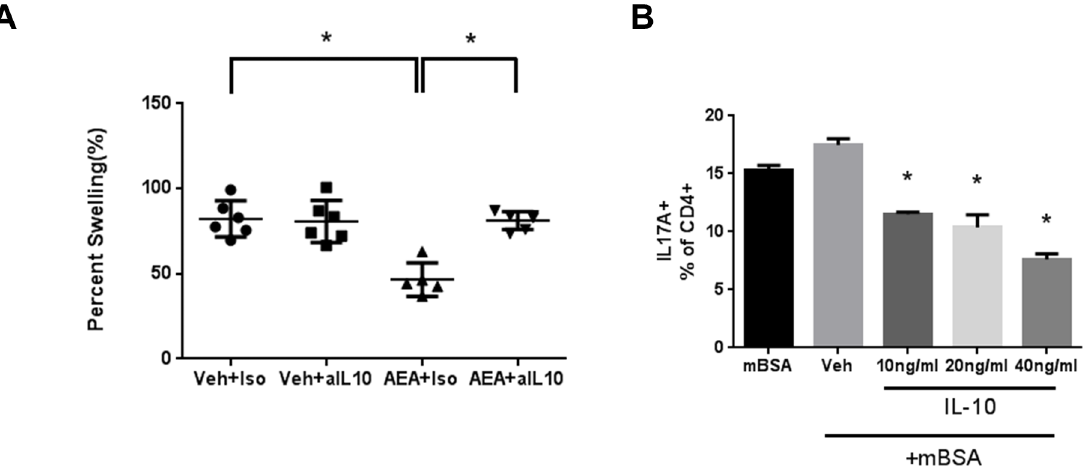
Figure 4. AEA suppresses DTH through IL-10 secretion. [A] Mice were sensitized to mBSA and treated with Vehicle or AEA, as described in Fig 1. An IL-10 neutralizing antibody or isotype control was given i.p. 1 hour before each treatment with AEA or vehicle, and [A] footpad swelling was measured. Footpad swelling data are a combination of 2 individual experiments with n=3 for Veh and n=3 for AEA. One mouse was excluded in both AEA treated groups because it was unclearly labeled. [B] Cells were isolated from the LN of mice sensitized to mBSA, plated, and cultured as described in Fig 3. rIL-10 was added to these cultures at 10, 20, or 40 ng/ml to assess the ability for IL-10 to knockdown the mBSA-induced Th17 response. Cells were cultured for 24 hours, and in the last 4 hours of culture, the cells were stimulated with PMA, Ionomycin, and Golgi Plug. Cells were harvested and stained for IL-17 + CD4 T cells. Data are representative of 3 individual experiments with n=3. *p , 0.05.